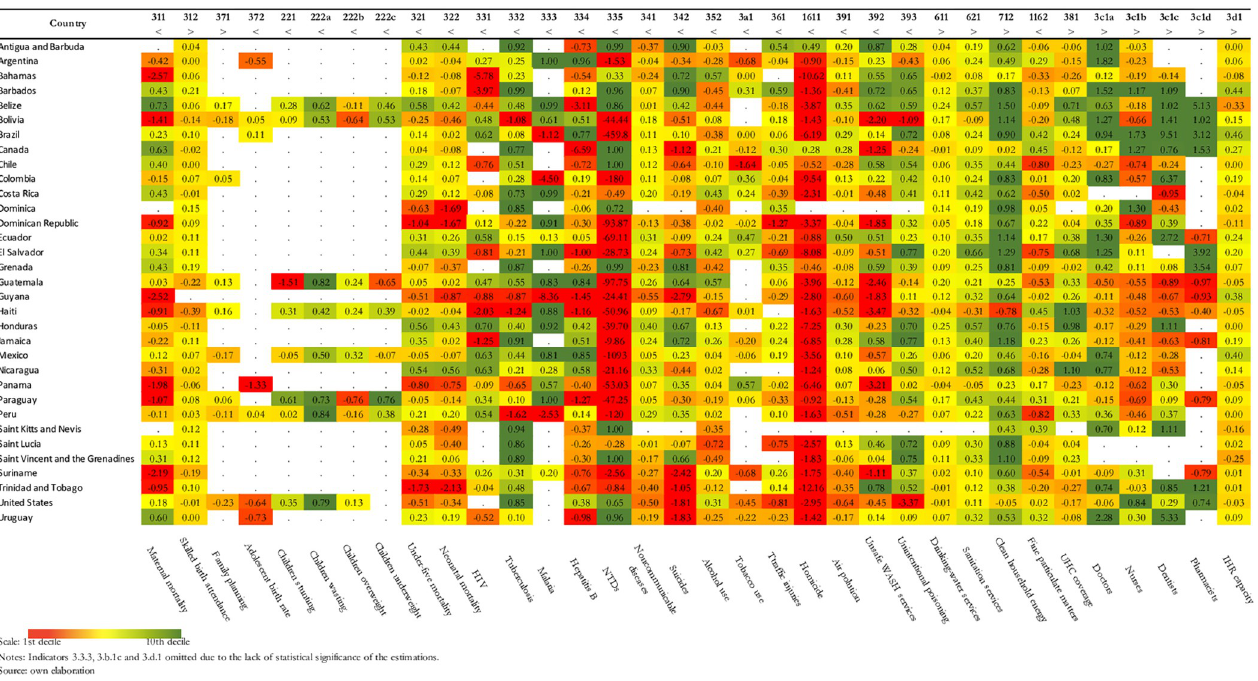
Fig 1. Current health gap scorecard: American countries. Notes: Indicators 3.b.1a,b,c and 17.19.2 omitted due to the lack of statistical significance of the estimations. The gap index was adjusted to indicate improvement upwards and worsening downwards regardless of the direction of improvement of the indicator. For example, mortality and health coverage indicators show improvement in opposite directions (indicated in the first column of the table), decreasing in the former ( < ) and increasing ( > ) in the last. Source: own elaboration.